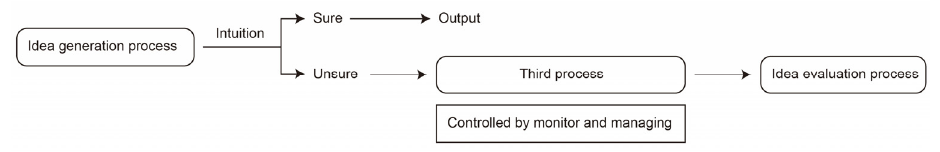
Figure 9. Tripartite-process model.